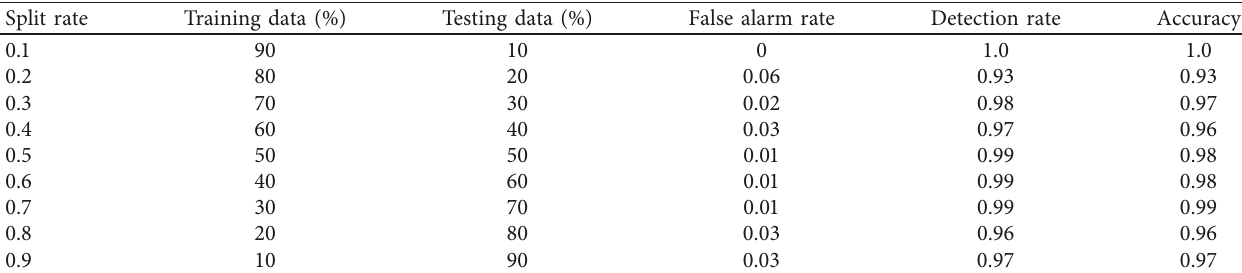
Figure 20: System flow of the proposed classification method. Table 2: Evaluation of prediction performance of ASVM